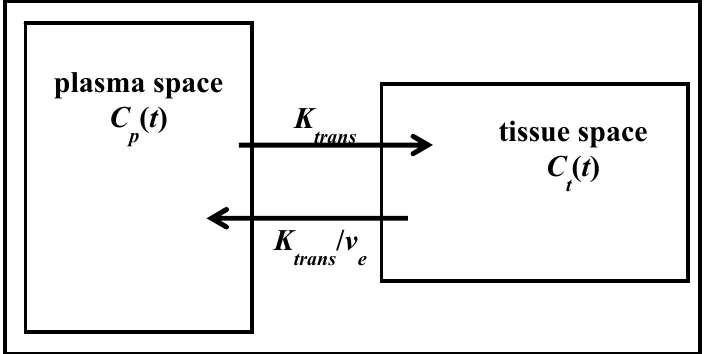
Figure 3. Two compartment model showing one compartment representing the plasma space while the other compartment is the tissue space. The contrast agent leaves the plasma space at a rate represented by K trans (the volume transfer constant) and returns by K trans / v (the efflux